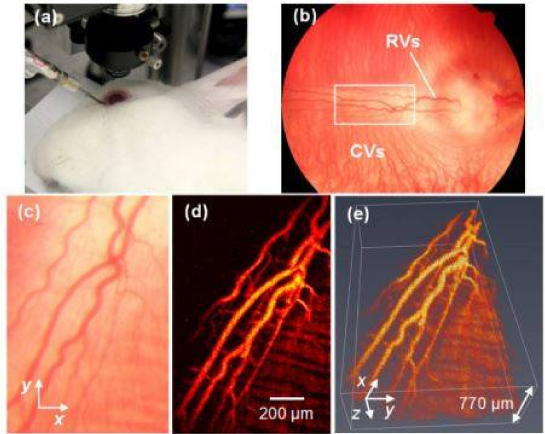
Figure 2. PAM imaging of retinal blood vessels in rabbits. ( a ) Experimental photograph showing the rabbit, the ophthalmic lens, and the ultrasound transducer; ( b ) Fundus photograph showing rabbit retinal vessels (RVs) originating from the optic nerve are confined in the medullary ray regions; ( c ) Close-up of the RVs in the white rectangle box in ( b ); ( d ) Maximum intensity projection (MIP) of PAM signals of RVs and choroidal vessels (CVs); ( e ) 3D volumetric rendering of the PAM image. Reproduced with permission from